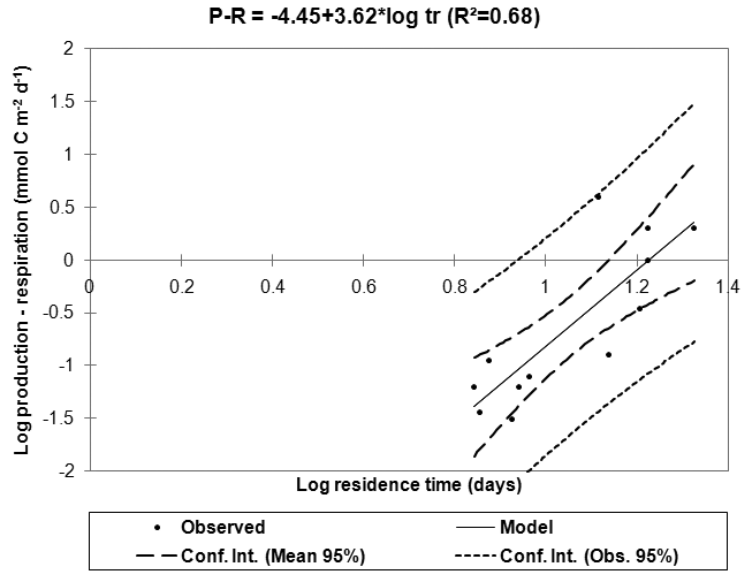
Fig. 7 – Budget monthly ( p - r ) as a function of the system exchange time (days).